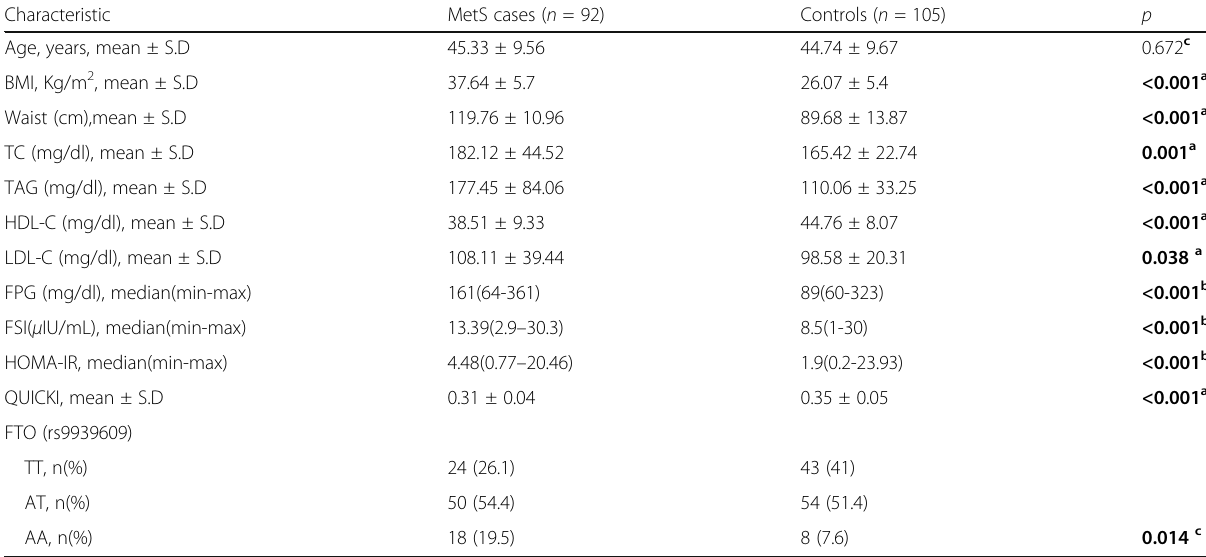
Table 1 Characteristics of MetS cases ( n = 92) and controls ( n = 105) Characteristic Age, years, mean ± S.D Waist (cm),mean ±